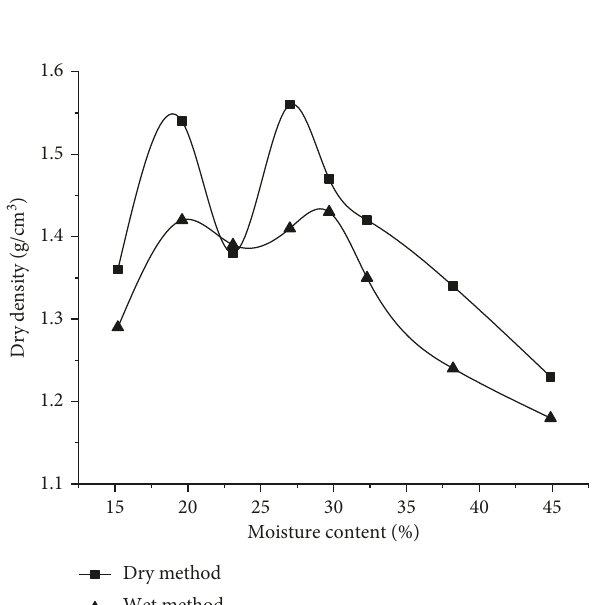
Figure 1: Granular grading of gravel.